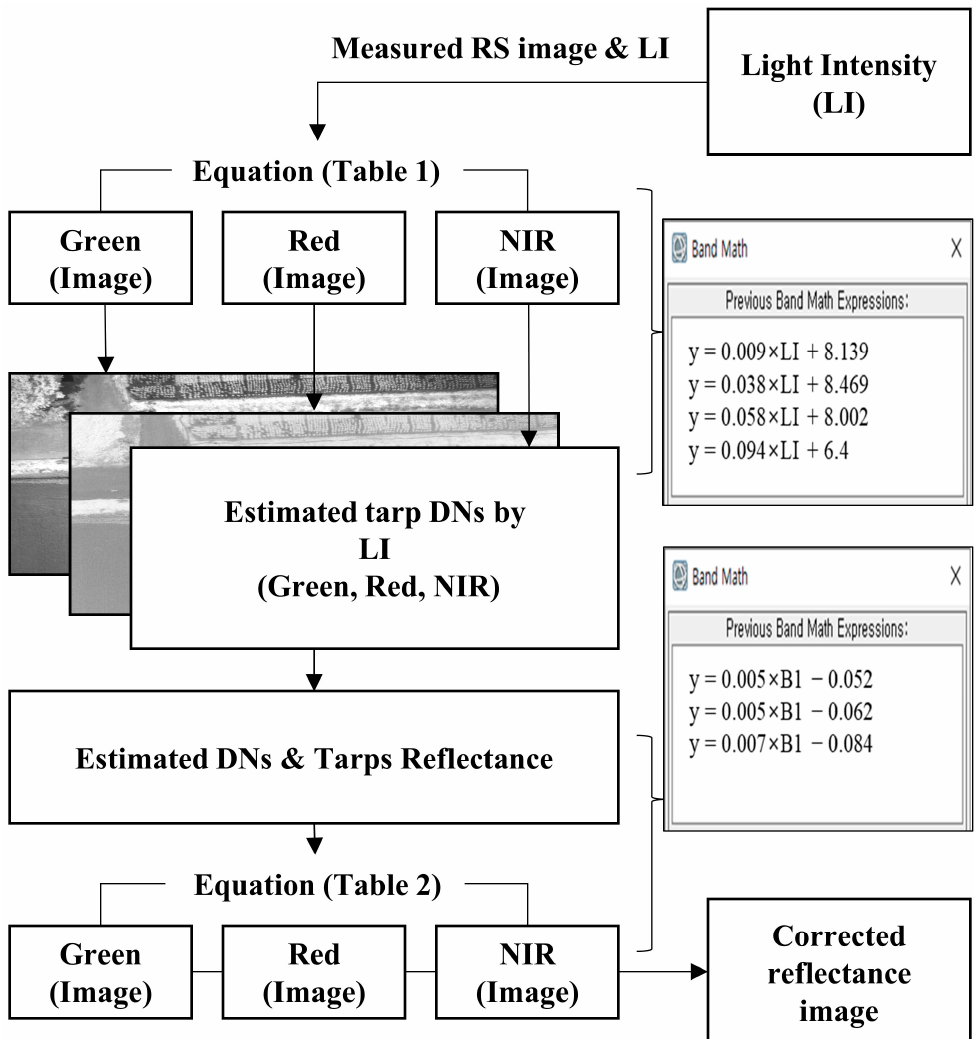
Figure 3. Schematic representation of the image processing employed to correct reflectance values of